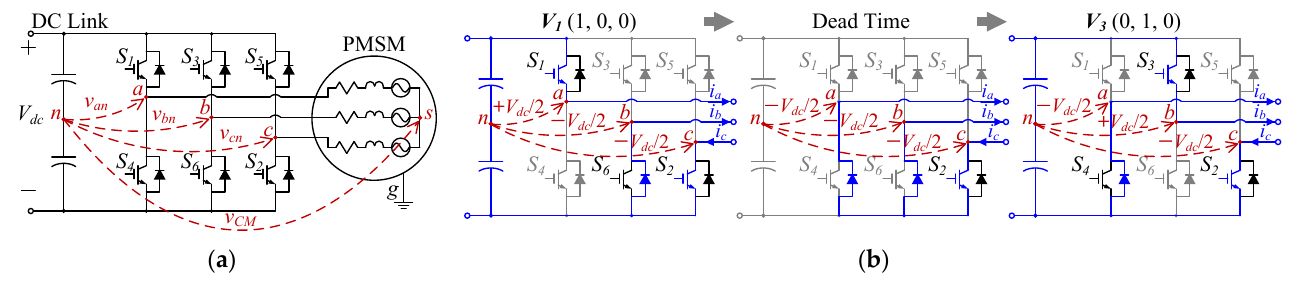
Figure 1. Circuit configuration and operation of H6 inverter: ( a ) Circuit configuration; ( b ) Circuit operation when voltage vector changes from V 1 to V 3 .